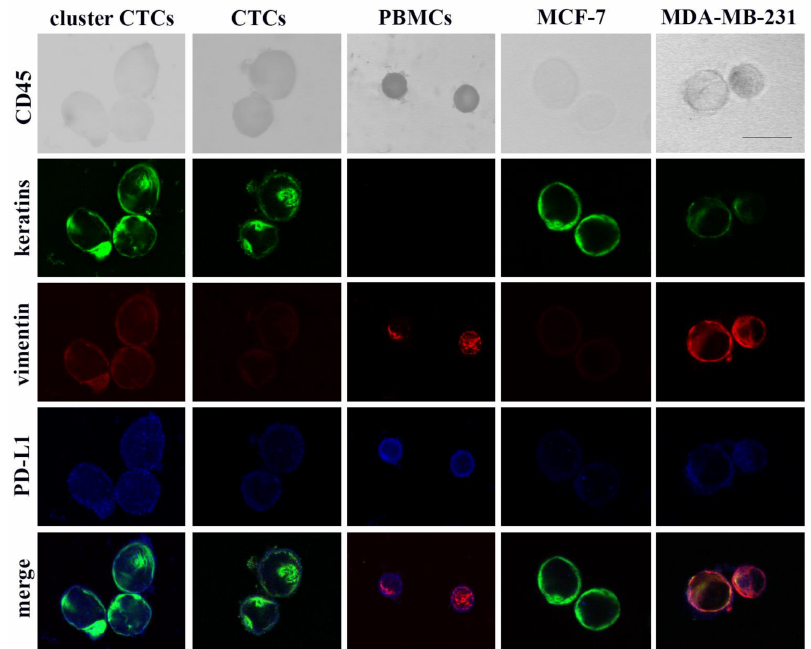
Figure 1. Quadruple immunostaining of PBMCs, CTCs and breast cancer cells. Representative images from cytospin preparations of PBMCs, CTCs, MCF-7 and MDA-MB-231 cells simultaneously stained for CD45, keratins, vimentin and PD-L1 are presented. Scale bar, 15 µ